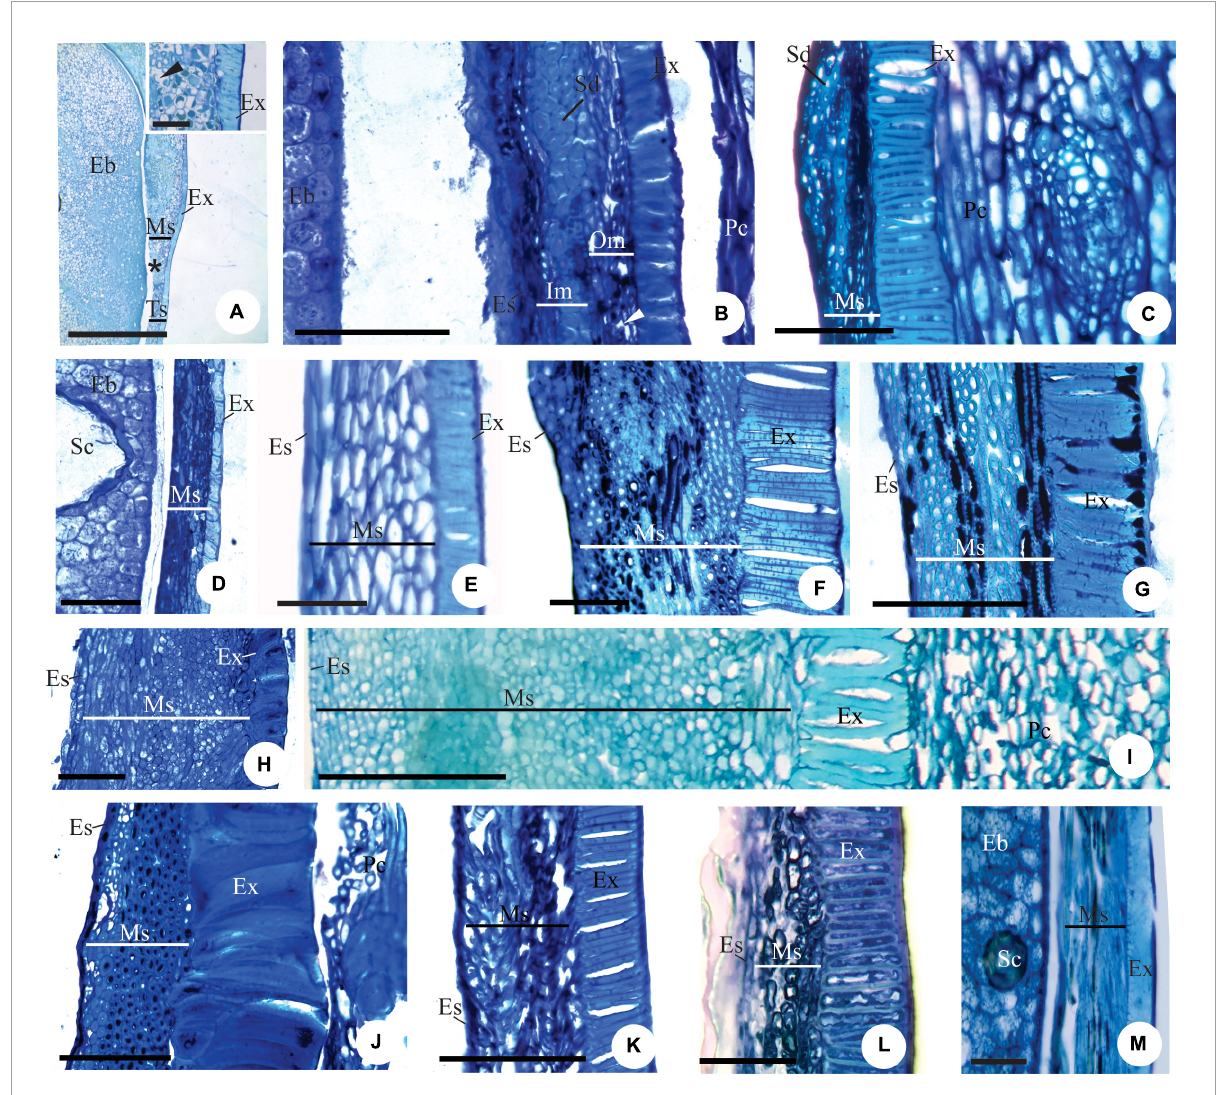
FIGURE5 Details of longitudinal sections of mature seed showing the pachychalazal (A–C,F–J) and testal (D,K–M) seed-coat of Eugenia subterminalis (A) , E. excelsa (B) , E. florida (C) , E. modesta (D) , E. paracauana (E) , E. bahiensis (F) , E. hirta (G) , E. leptoclada (H) , E. neoverrucosa (I) , E. flavescens (J) , E. batingabranca (K) , E. egensis (L) , and E. hiemalis (M) . Note the exotesta constituted by a palisade of radially elongated lignified macroesclereids (A–C,E–L) . In photos (D,M) these cells are cuboidal in shape. Note the exotestal seed in photos (A,D,E,H,I,K,L) , exomesotestal in photos (B,C) and testal in photos (F,G) . Eb, embryo; Es, endotesta; Ex, exotesta; Im, inner mesotesta; Ms, mesotesta; Om, outer mesotesta; Pc, pericarp; Vp, pachychalazal vascular bundle; (cid:73) , intercellular space. Scale bars = 25 µ m (M) , 50 µ m (G,L) , 100 µ m (B–D,F,H,J,K) , 200 µ m (I) , 400 µ m (A) .